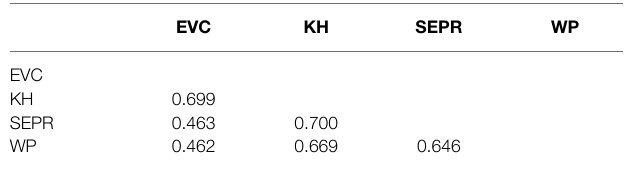
TABLE 4 | HTMT (Heterotrait-Monotrait Ratio) of